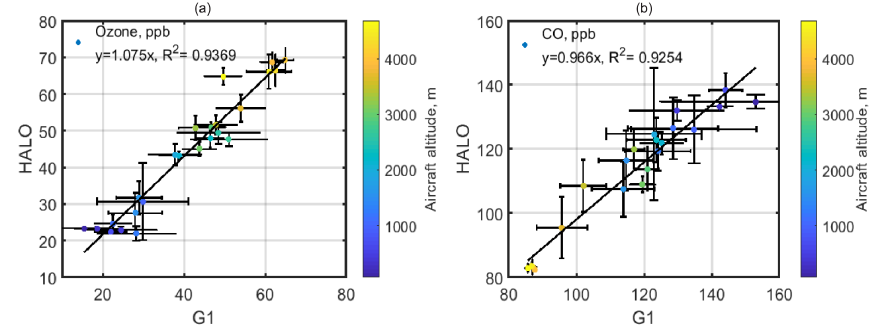
Figure 5. Aircraft altitude-colored plots of trace gas (a) ozone and (b) CO for the coordinated flight on 21 September.